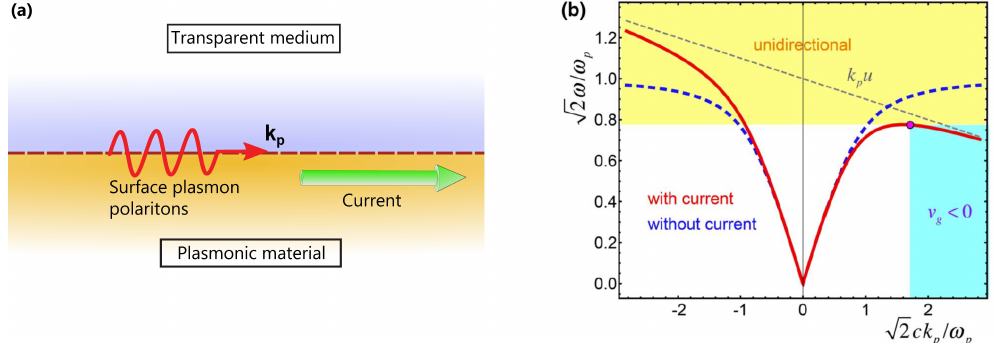
Figure 9. Current-induced unidirectional surface plasmon-polariton modes at a plasma-vacuum interface. ( a ) Geometry of the system. ( b ) Surface modes dispersion diagram with and without current bias. Interestingly, the system supports a region of zero and negative group velocity, due to highly confined surface plasmon-polaritons being dragged backward by the electron flow. A fundamental difference between the SPP modes on a magnetized plasma (Figure 4) and on a current-biased plasma is that here the unidirectional region has no upper frequency limit in the ideal lossless case (losses will make the dispersion bands bend backward as in Figure 4d). ( b ) reproduced with permission from [81].